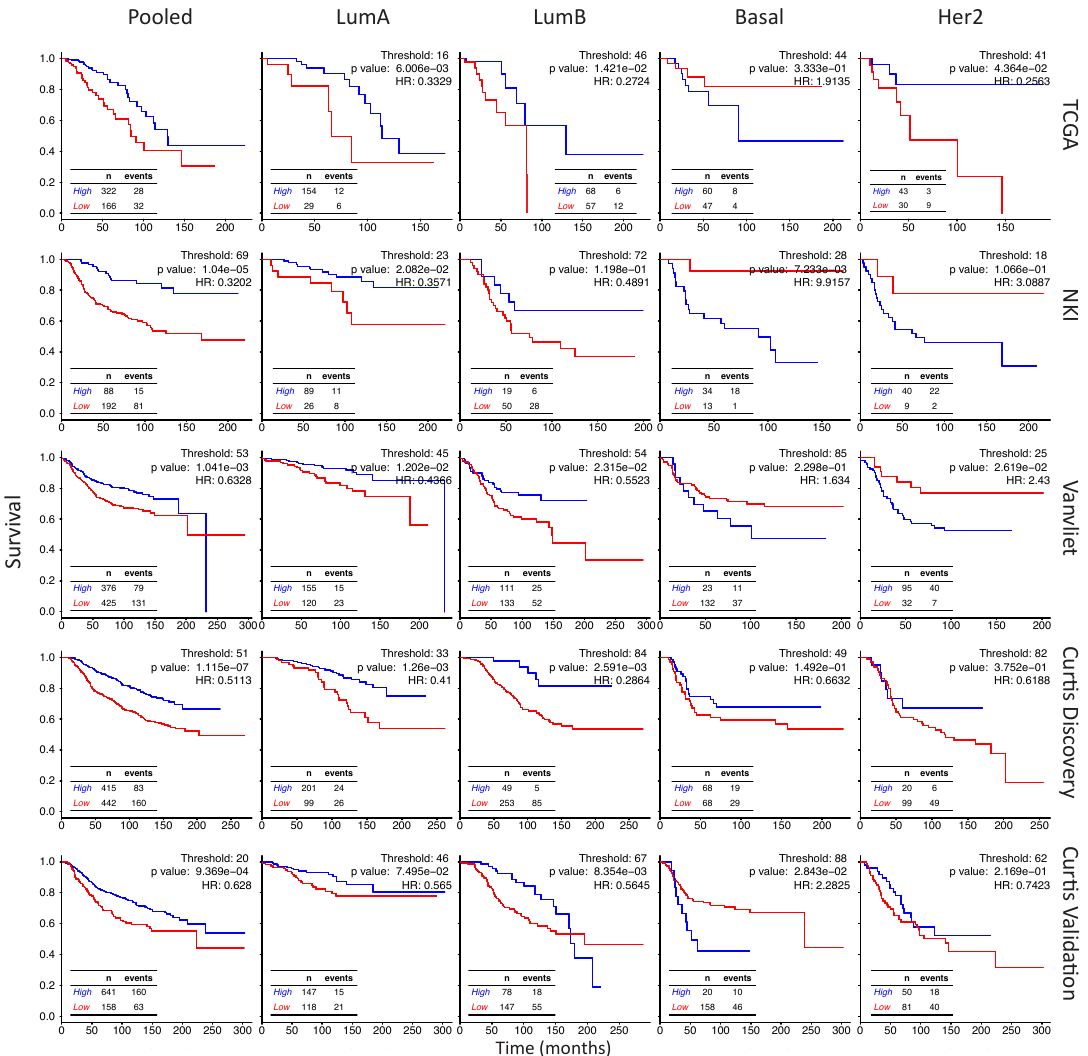
Figure A9. Survival analysis of GJA1 in individual subtypes of breast cancer with cutoff selected according to the ROC curve. Kaplan–Meyer plots show survival curves for patients with breast tumors expressing either high (blue) or low (red) levels of GJA1 mRNA in pooled tumors or in individual intrinsic subtypes. TCGA, NKI, Vanvliet and both Curtis datasets were used for the analysis. The best cutoff was determined from ROC curves as in Figure